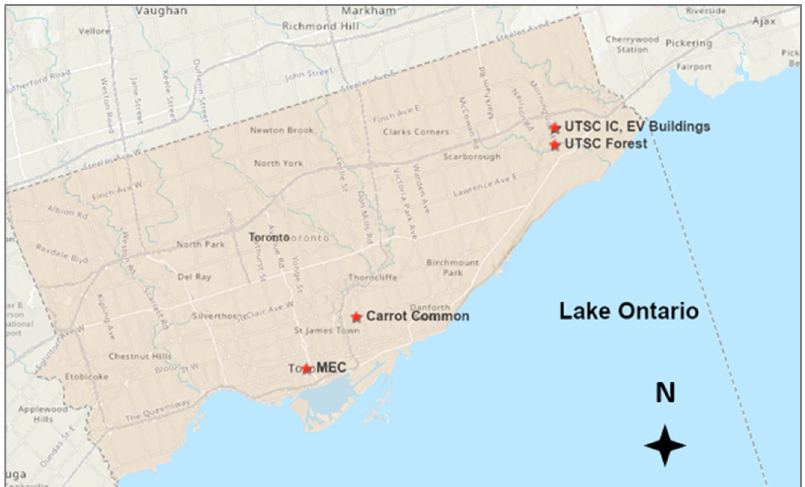
Figure 2. Map of study sites (marked by red stars ) in Toronto, Ontario, Canada. Sites include: MEC (Mountain Equipment Co-op: a . extensive green roof); Carrot Common: a . semi-intensive vegetable growing roof, b . extensive green roof, c . green wall, d . rooftop medicine garden; UTSC Forest (2 sites); UTSC IC (Instructional Centre: a . rooftop fruit and vegetable garden), and UTSC EV (Environmental Science and Chemistry Building: a . extensive green roof) [6].